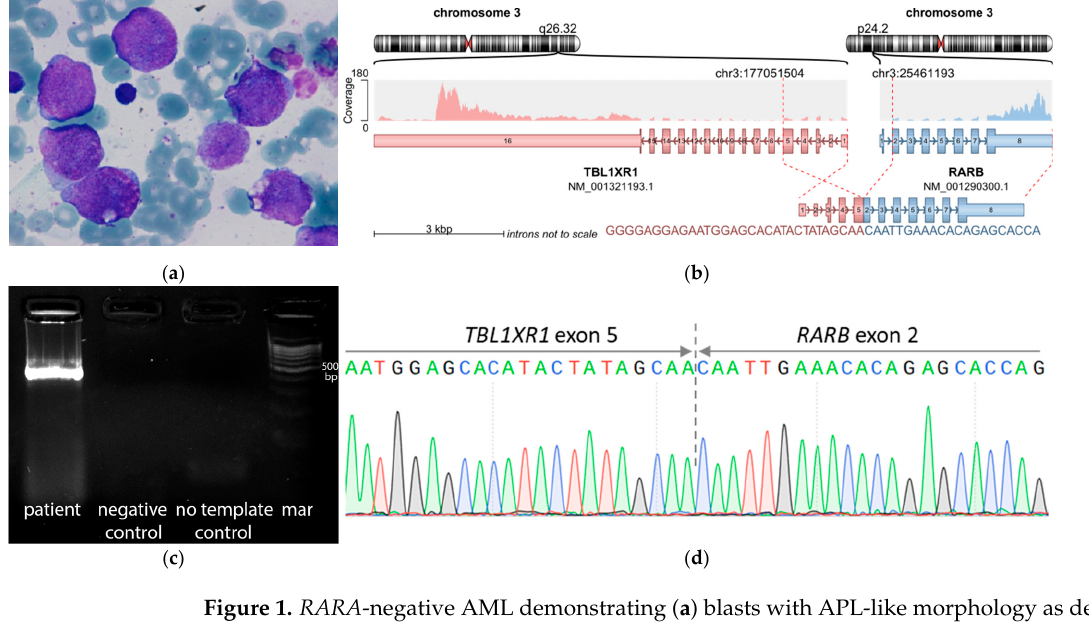
Figure 1. RARA -negative AML demonstrating ( a ) blasts with APL-like morphology as depicted by Pappenheim–Kryukov staining in BM smear, ( b ) TBL1XR1::RARB fusion transcript in RNAseq data, ( c ) RT-PCR and ( d ) Sanger validation on TBL1XR1::RARB fusion transcript (for primers, see Table S1). Fusion-negative AML with APL-like morphological features did not carry any recur- rent chromosomal aberrations. They included two cases of non-recurrent chromosomal rearrangements and three AMLs with normal karyotype. Additional mutations affected PTPN11 , NRAS , IDH2 and a single case of NPM1 insertion and FLT3-ITD co-occurrence. Nonsynonymous deleterious exonic variants are listed in Table S3. The overall morpho- logical, immunophenotypic and molecular heterogeneity of pediatric AML with atypical promyelocytes accumulation is summarized in Table 1.